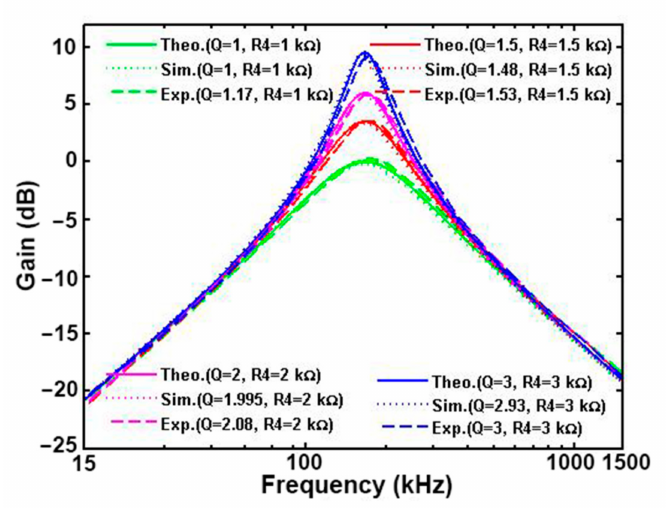
Figure 33. The Q parameters of NBPF at the output of V BP5 by varying R 4 while keeping f o .